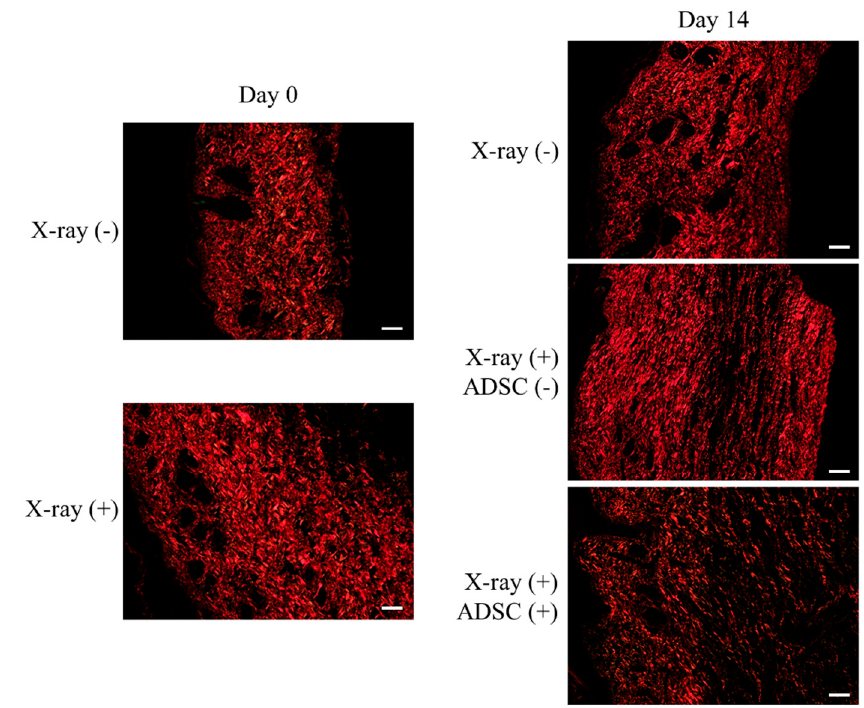
Figure 4. Evaluation of fibrosis using picrosirius red staining. Representative images of picrosirius red staining observed by polarizing microscope. Scale bars (magnification): 50 µm (200×). Table 3. Percentage of red and green channel area stained by picrosirius red (mean% ± SE). X-ray Day 0 X-ray / ADSC Day 14 − Red